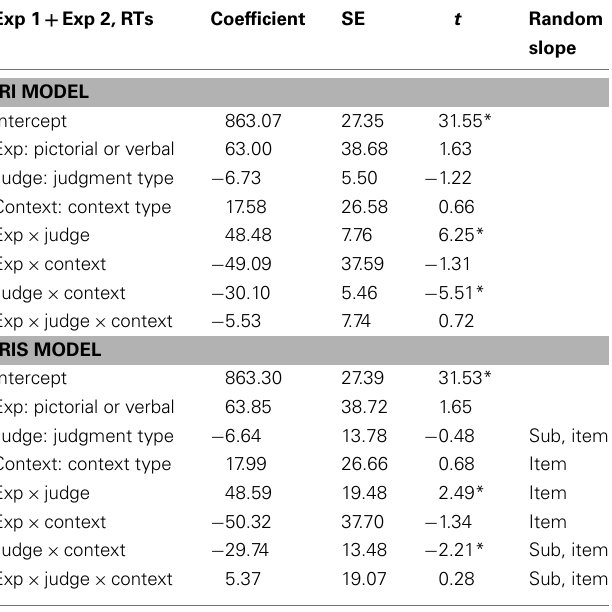
Table 5 |The linear mixed-effects regression models on the reaction times for the (picture and word)